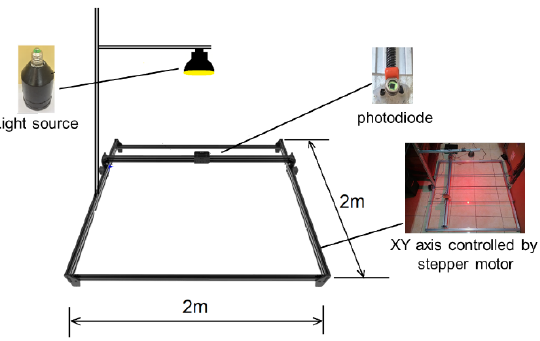
Figure 13. Experimental setup of light distribution measurements.